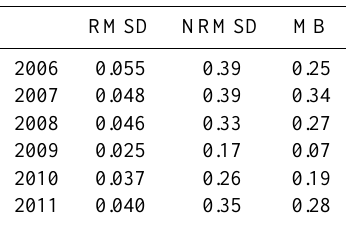
Table 4. Evaluation of the simulated seasonal volumetric soil mois- ture via the root mean square difference (RMSD, mmmm − 1 ), nor- malised RMSD (NRMSD), and model bias (MB) at Level Forest site, Marmot Creek Research